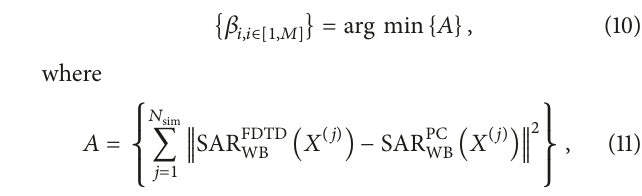
input parameters by expansion in an orthogonal polynomial basis, such as the Legendre